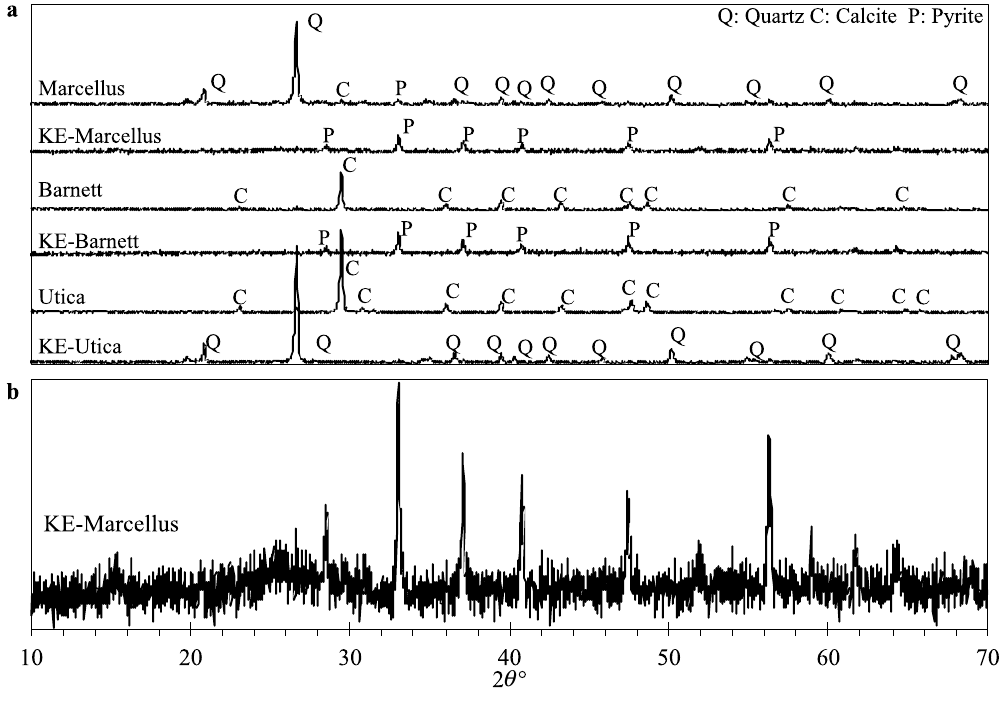
Figure 6. XRD patterns of shales and kerogen-enriched shales ( a ) and KE-Marcellus ( b